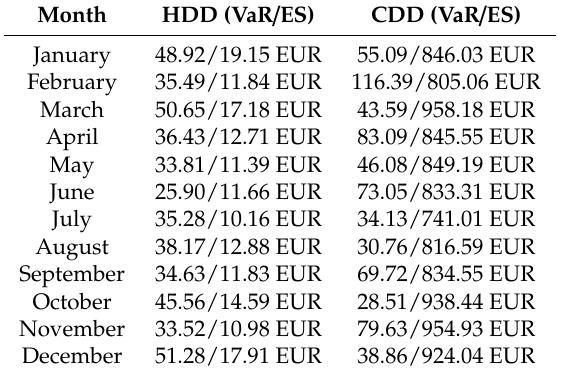
Table 4. Pure financial derivative values for HDD and CDD computed from data simulated